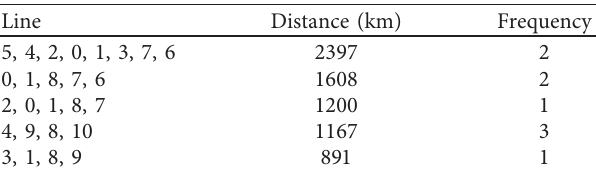
Table 6: Best line plan information of PDS 1 obtained by MHIA on the small HSR